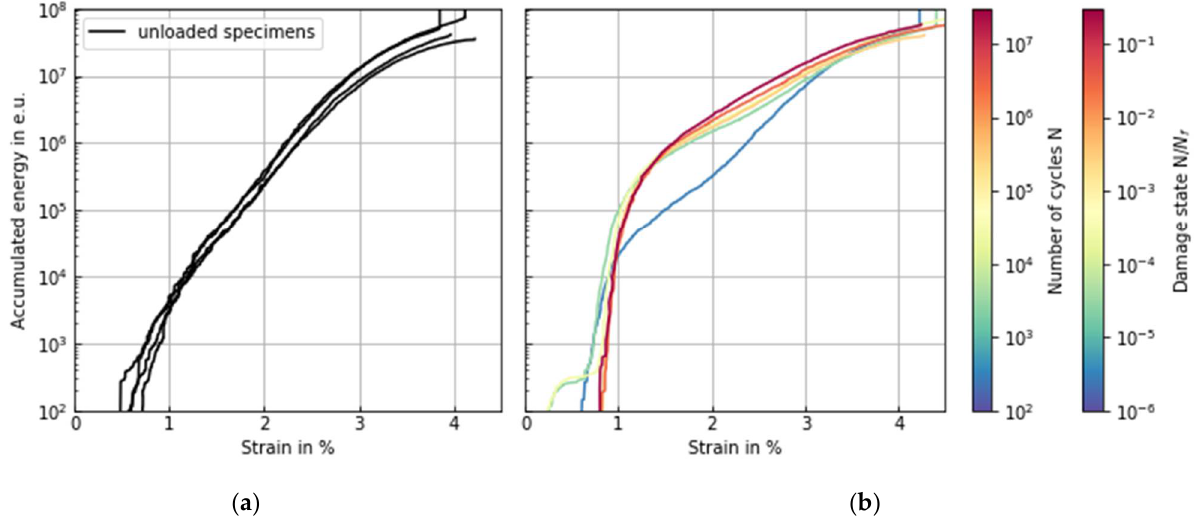
Figure 8. Accumulated acoustic energy in energy units (1 e.u. ≙ 1×10 −21 J): ( a ) unloaded specimens; ( b ) preloaded specimens sorted by damage state.